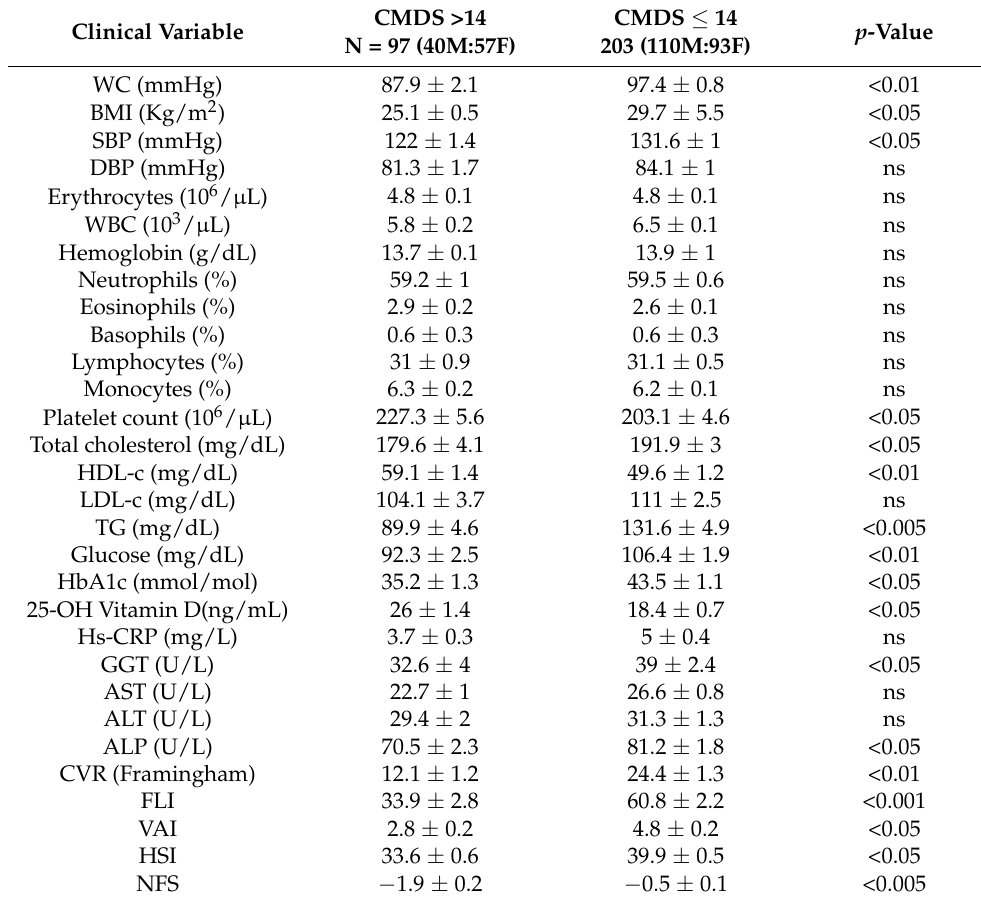
Table 4. Baseline characteristics comparison of patients divided in two groups according to Chrono- Med Diet cut-off to identify increased visceral